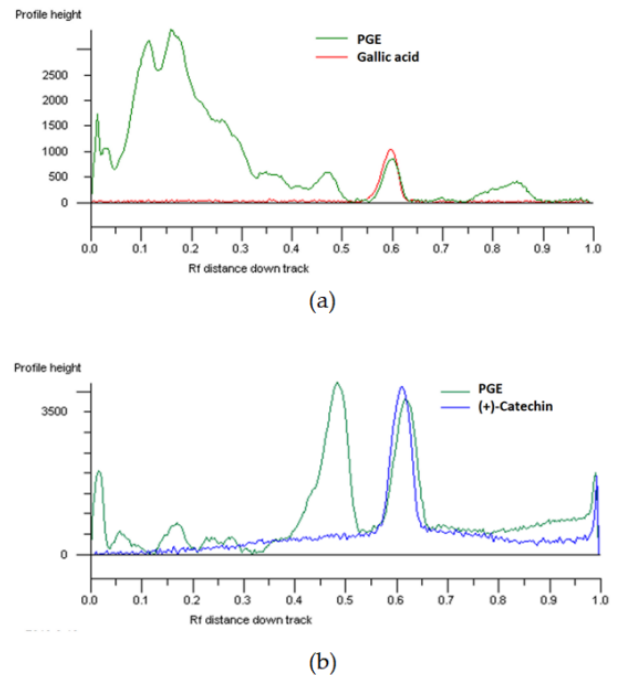
Figure 1. HPTLC chromatogram of the ethyl acetate extract, obtained by Soxhlet from the waste peel of Punica granatum L. var. Dente di Cavallo DC2 (PGE), and the standard gallic acid ( a ; Rf 0.58–; visualization under UV 366 nm after NPR derivatization) and ( + )-catechin ( b ; Rf 0.58–UV 366 nm after derivatization with NPR and anisaldehyde). Table 2. HPLC-PDA analysis of phenolics identified in the ethyl acetate extract, obtained by Soxhlet from the waste peel of Punica granatum L. var. Dente di Cavallo DC2 (PGE) ( n =